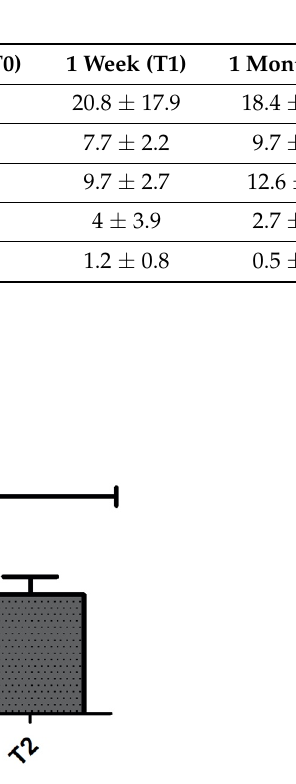
Figure 1. Improvement of symptoms over time recorded via the OSDI questionnaire. The black horizontal line represents the limit value between severe (above) and moderate (below) dry eye. (ANOVA p < 0.0001).